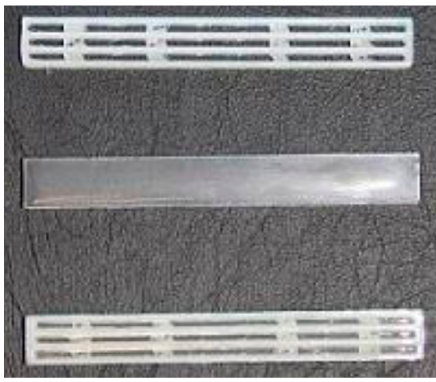
Figure 2. Representative images of the prepared PCL(3D), EP, and EP-PCL(3D) samples.